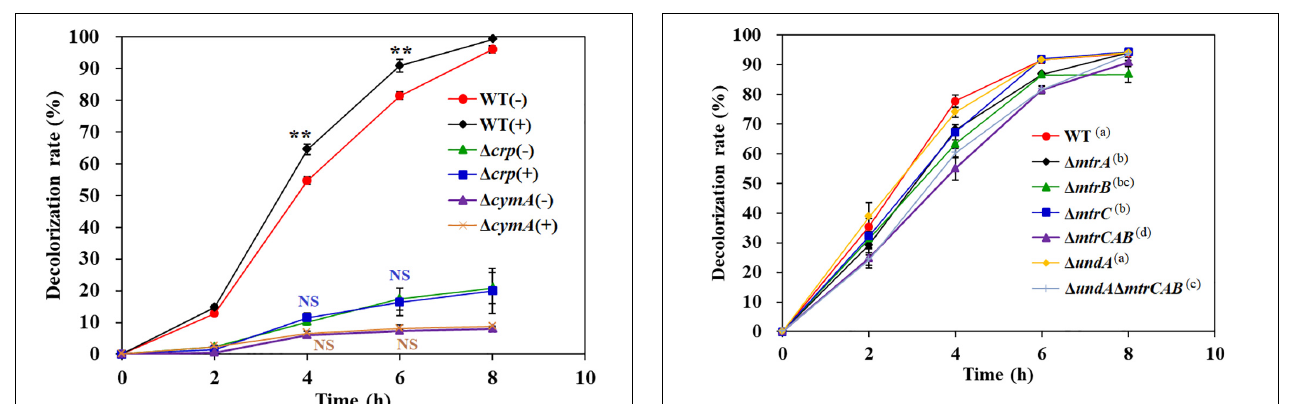
FIGURE 6 | The effect of exogenous riboflavin on AY decolorization. Values are means ± SD ( n = 3). The cells were cultured in decolorization medium with (+) or without (–) adding 2 µ M riboflavin. The initial AY concentration of is 200 mg/L. Significance analysis of decolorization rates of the same strain with and without riboflavin was performed using Student’s t -test; asterisks ** p < 0.01, and NS indicates not significant.